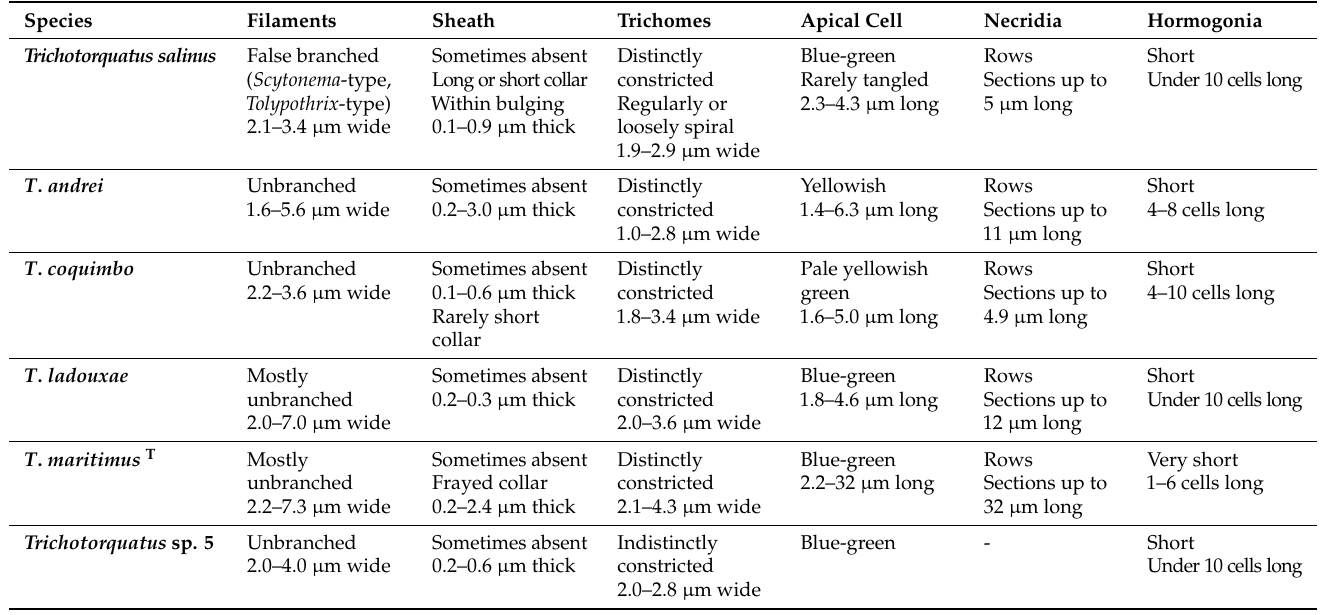
Table 1. Morphological characteristics of genus Trichotorquatus as described by Pietrasiak et al. [2].